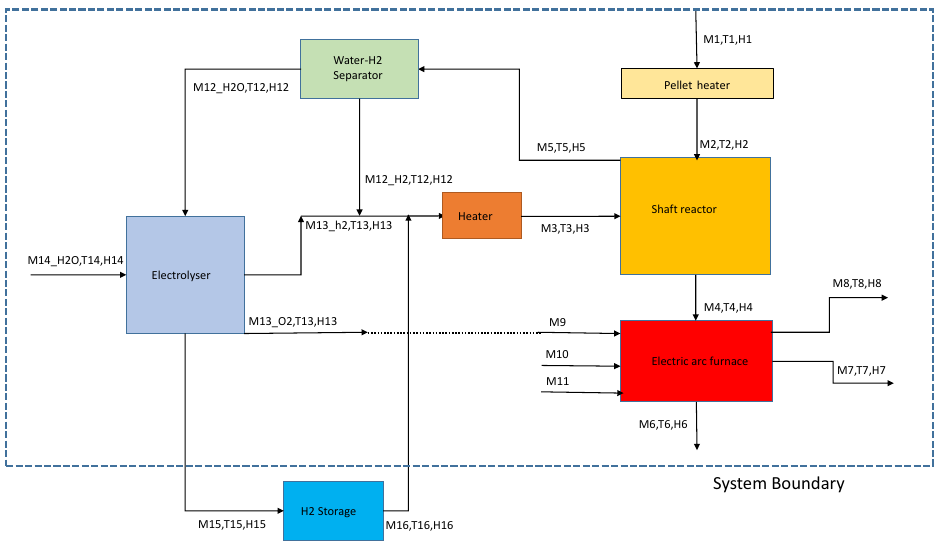
Figure 2. Schematic of the Hydrogen direct reduction shaft furnace coupled with an electric arc furnace. An electrolyzer is considered for hydrogen production.